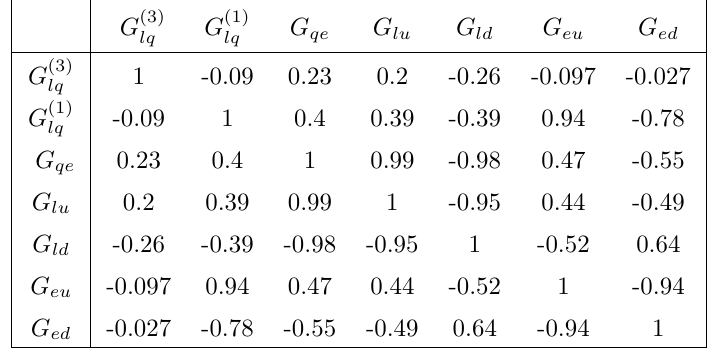
Table 10 . Correlation matrix for the linearized fit in the Warsaw